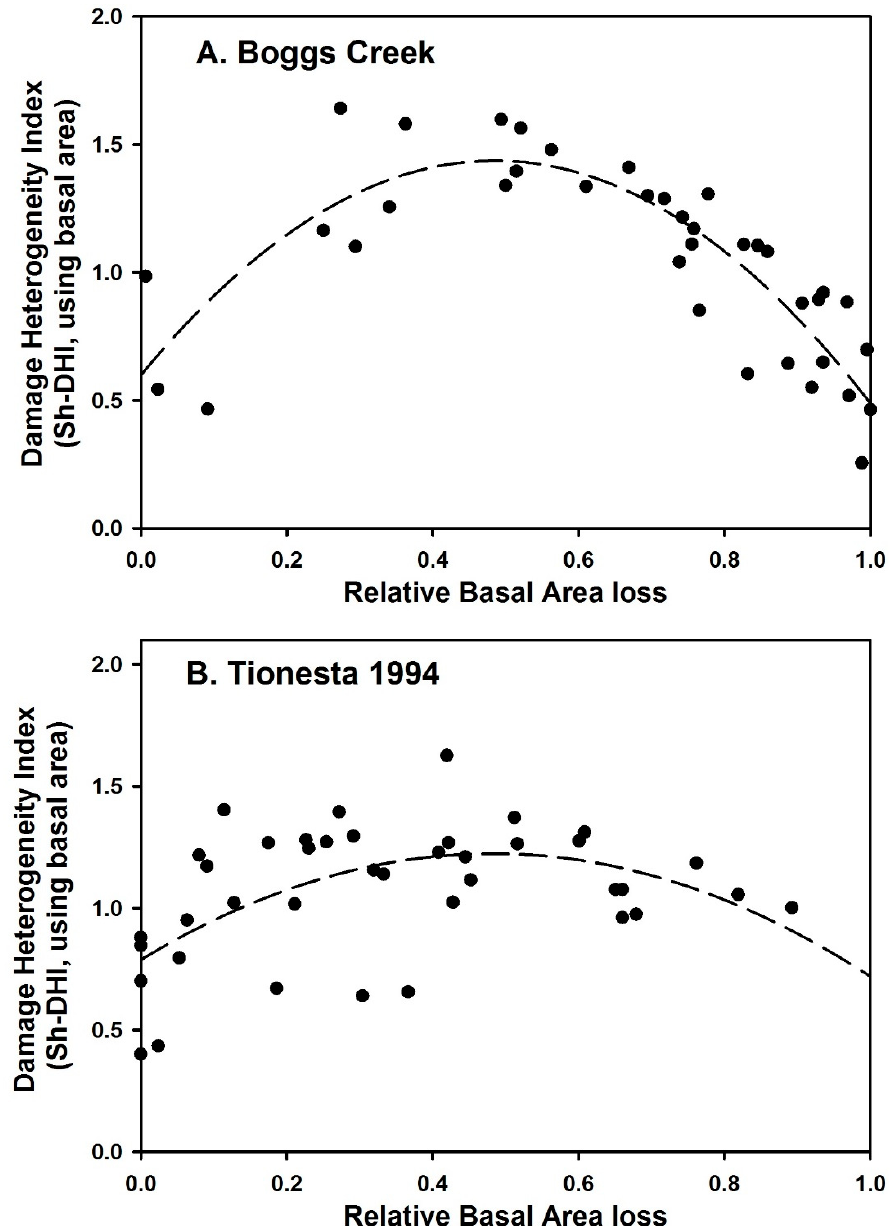
Figure 10. Damage heterogeneiety index (Sh-DHI) in relation to severity of damage, from two of the study sites. ( A ) Boggs Creek (linear R 2 = 0.124, quadratic R 2 = 0.726); and ( B ) Tionesta 1994 (linear R 2 = 0.106, quadratic R 2 = 0.298). In both panels, quadratic regression line is shown. In all calculations of damage heterogeneity above, the measure of abundance used was the cumulative basal area in each damage category for that plot.